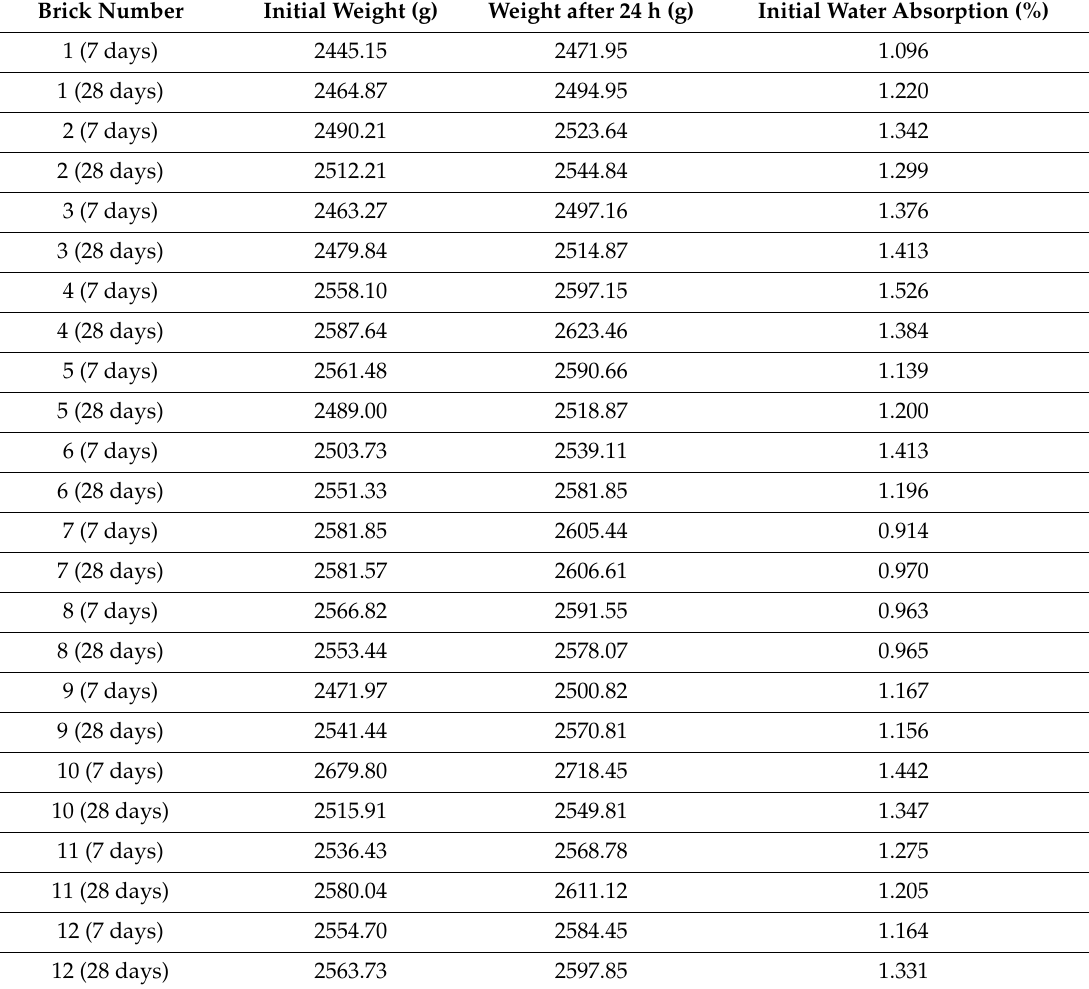
Table 3. Initial water absorption of the kimberlite